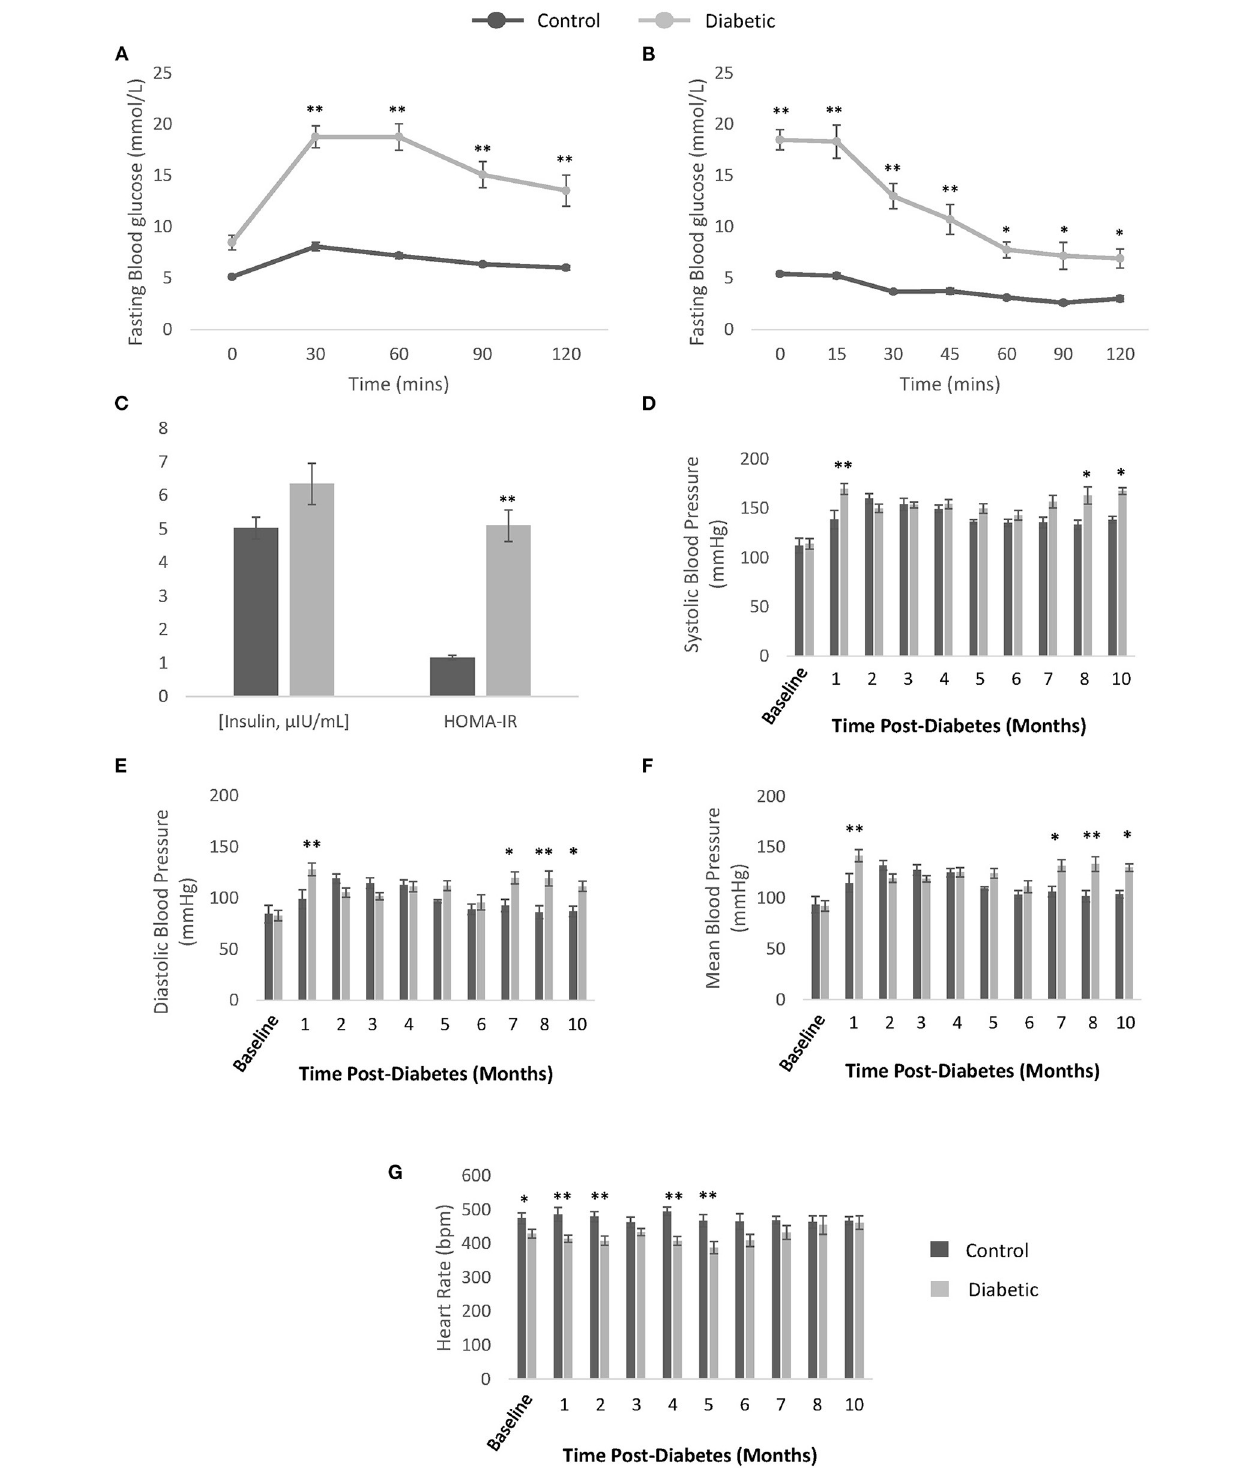
FIGURE 3 | Confirmation of type II diabetes and non-invasive blood pressure measurements. (A) Oral glucose tolerance test performed after overnight fasting in control ( n = 9) and diabetic ( n = 19) rats. (B) Insulin tolerance testing performed after 6-h fasting in control ( n = 9) and diabetic ( n = 19) rats. (C) Blood insulin levels measured from plasma collected after overnight fasting ( µ IU/mL) and Homeostatic Model Assessment of Insulin Resistance (HOMA-IR) calculated for control ( n = 7) and diabetic ( n = 14) rats. (D) Systolic blood pressure. (E) Diastolic blood pressure. (F) Mean blood pressure. (G) Conscious heart rate [beats per minute (bpm)]. Significance at individual timepoints is indicated (* p < 0.05), (** p < 0.01). Data represented as mean ± SEM.